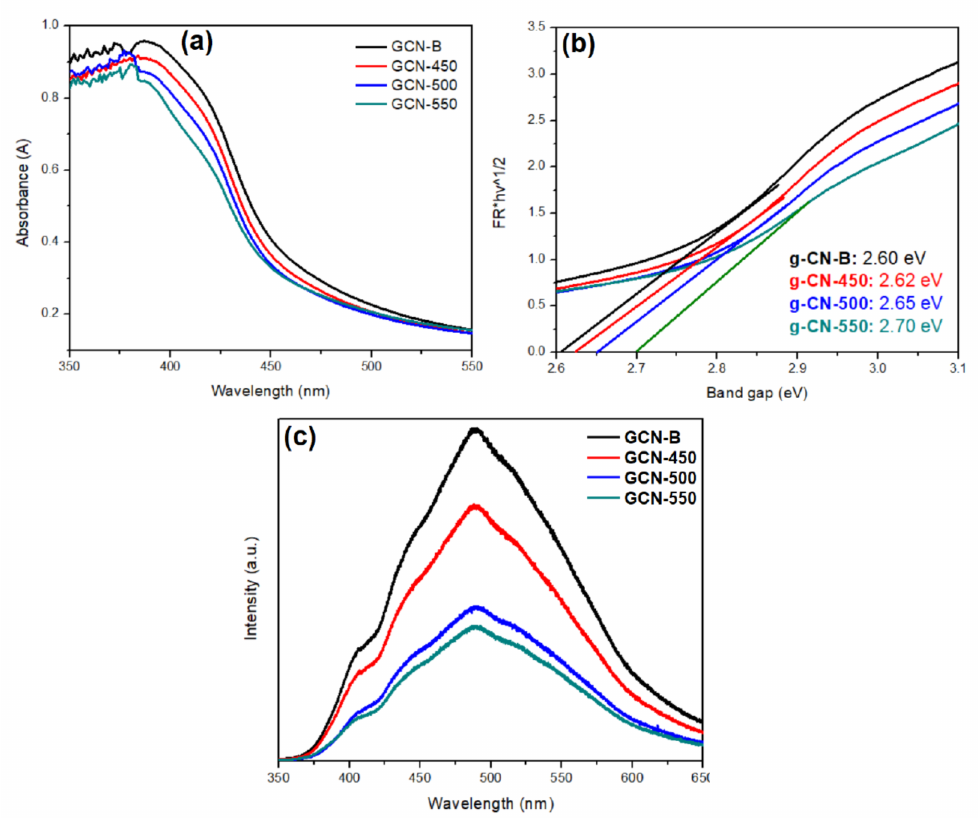
Figure 9. ( a ) UV–Vis absorption spectrum; ( b ) plots of ( α hv)1/2 vs. photon energy of the GCN-B and GCN that recalcined at different temperature; ( c ) PL spectra of GCN-B and GCN that recalcined at different